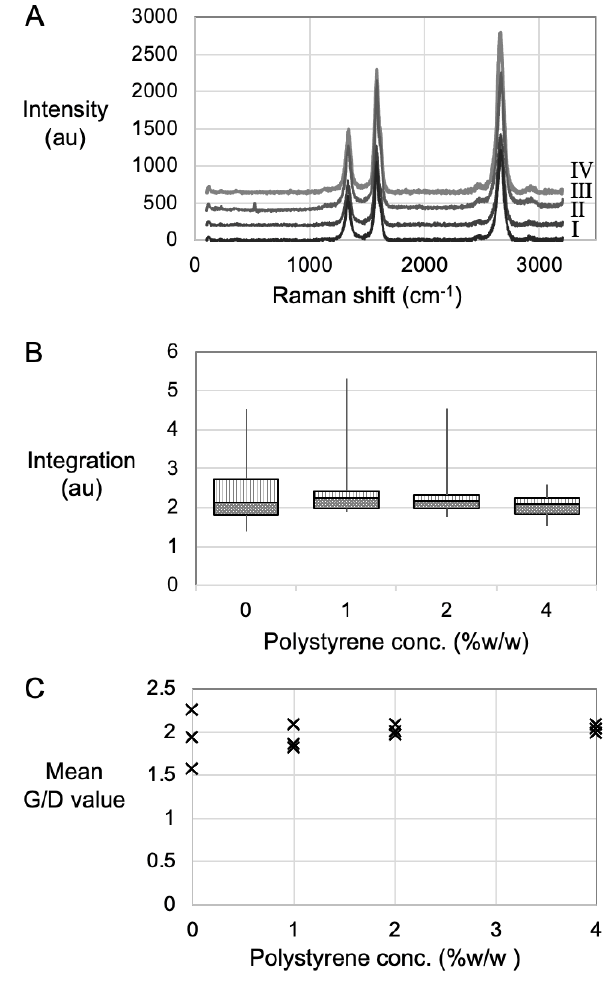
Figure 3. Raman data showing ( A ) typical spectra stacked from (I) Control, (II) PS 1 wt%, (III) PS 2 wt% and (IV) PS 4 wt%. ( B ) Box plot from line integration between 1400 – 1475 cm −1 , and ( C ) Mean G/D values. All spectra acquired using 633 nm laser.